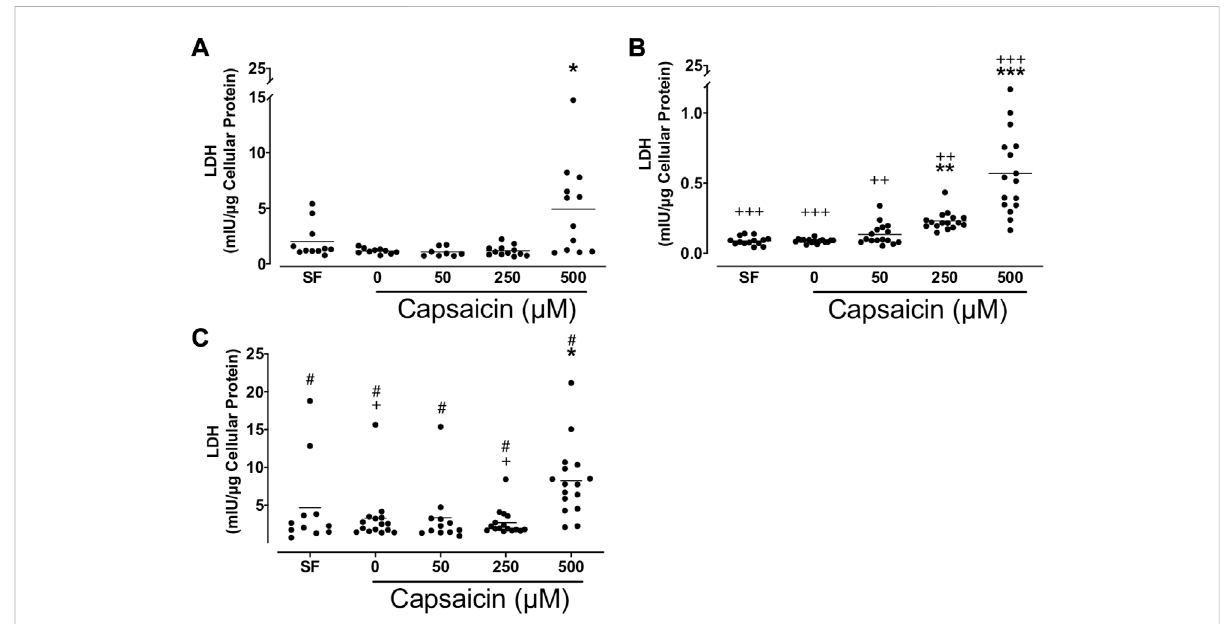
FIGURE 6 Effect of capsaicin (C) on the release of lactate dehydrogenase (LDH) of bronchial epithelial cells from non-smokers (A) , smokers (B) and patientswith COPD (C) .Individualdatapointswithmeansweredisplayedfor non-smokers, smokersandpatients withCOPD (* p < 0.01,** p <